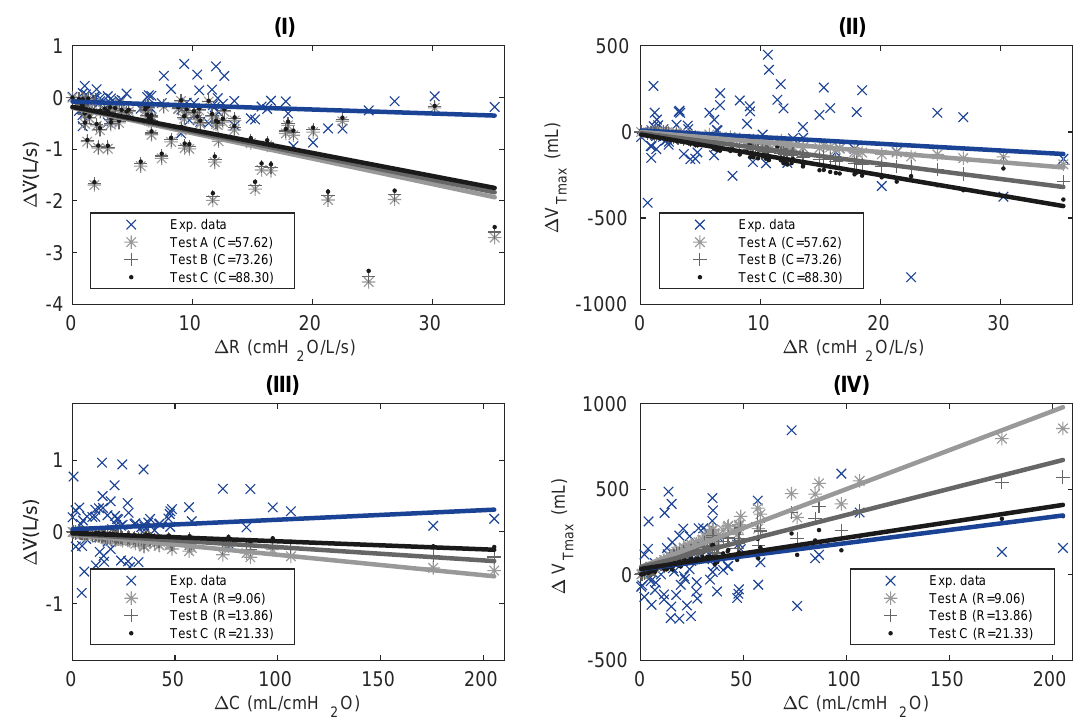
no statistically significant differences were found between each pair of data ( p -value of 0.81 and 0.09 for ˙ V and V Tmax , respectively).